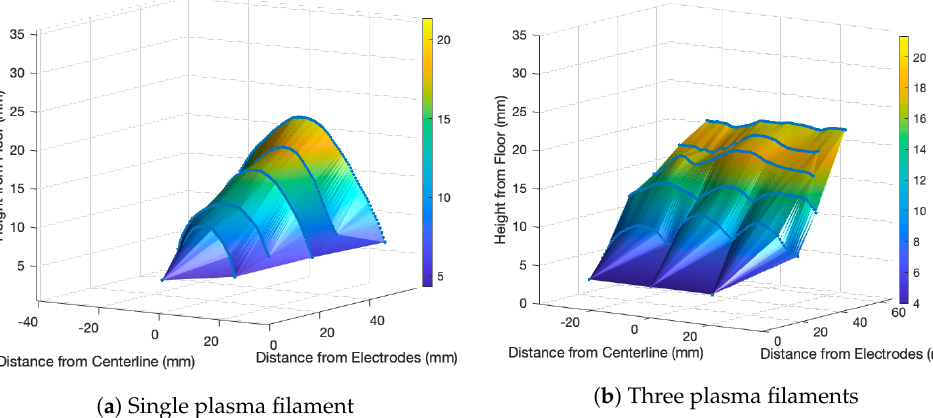
Figure 10. Resulting SW surfaces after merging plasma SW profiles taken from Mie scattering